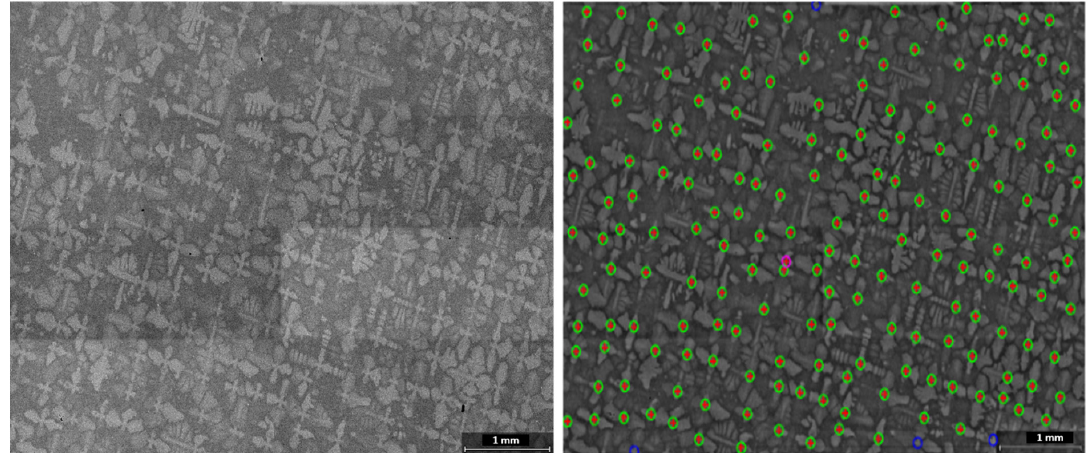
Figure 10. Final processed and mapped image. Dendrite cores are identified with red crosses. Green circles refer to manually selected cores, blue missed out cores, and purple circles detected cores that were omitted from the manual selection. The dendrites highlighted by the purple circles are false positives that have similar shape and intensity to a dendrite core but smaller size and are tertiary or secondary arms in nature.